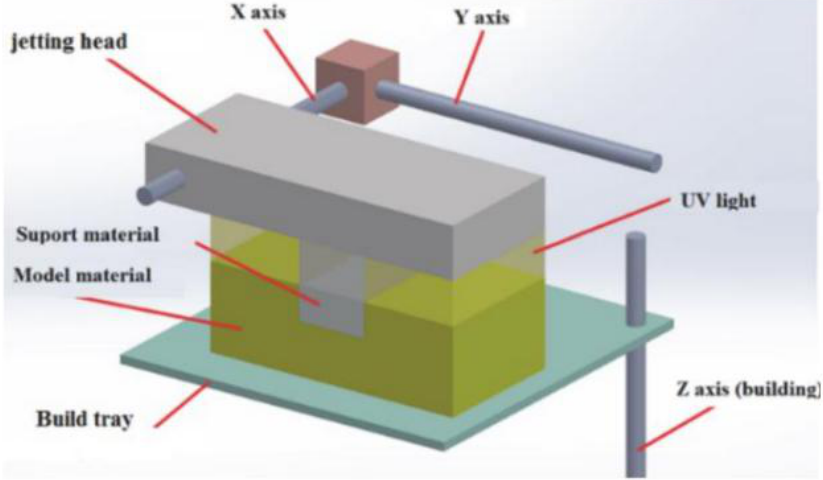
Figure 1. The process of producing models in a 3D printing technology—PJM. All specimen models were designed using SolidWorks software (Dassault Syst è mes SolidWorks Corp., Waltham, MA, USA), and then saved as STL files in the so-called adapted save mode, with the parameters of deviation tolerance of 0.01, and angular tolerance of 5 ◦ . Next, the STL files were subjected to approximation verification using Magics 15.0 (Materialise, Belgium). After verification, digital models of the specimens were arranged on a virtual 3D printer platform. Models were made using a High-Quality mode and layer thickness of 0.016